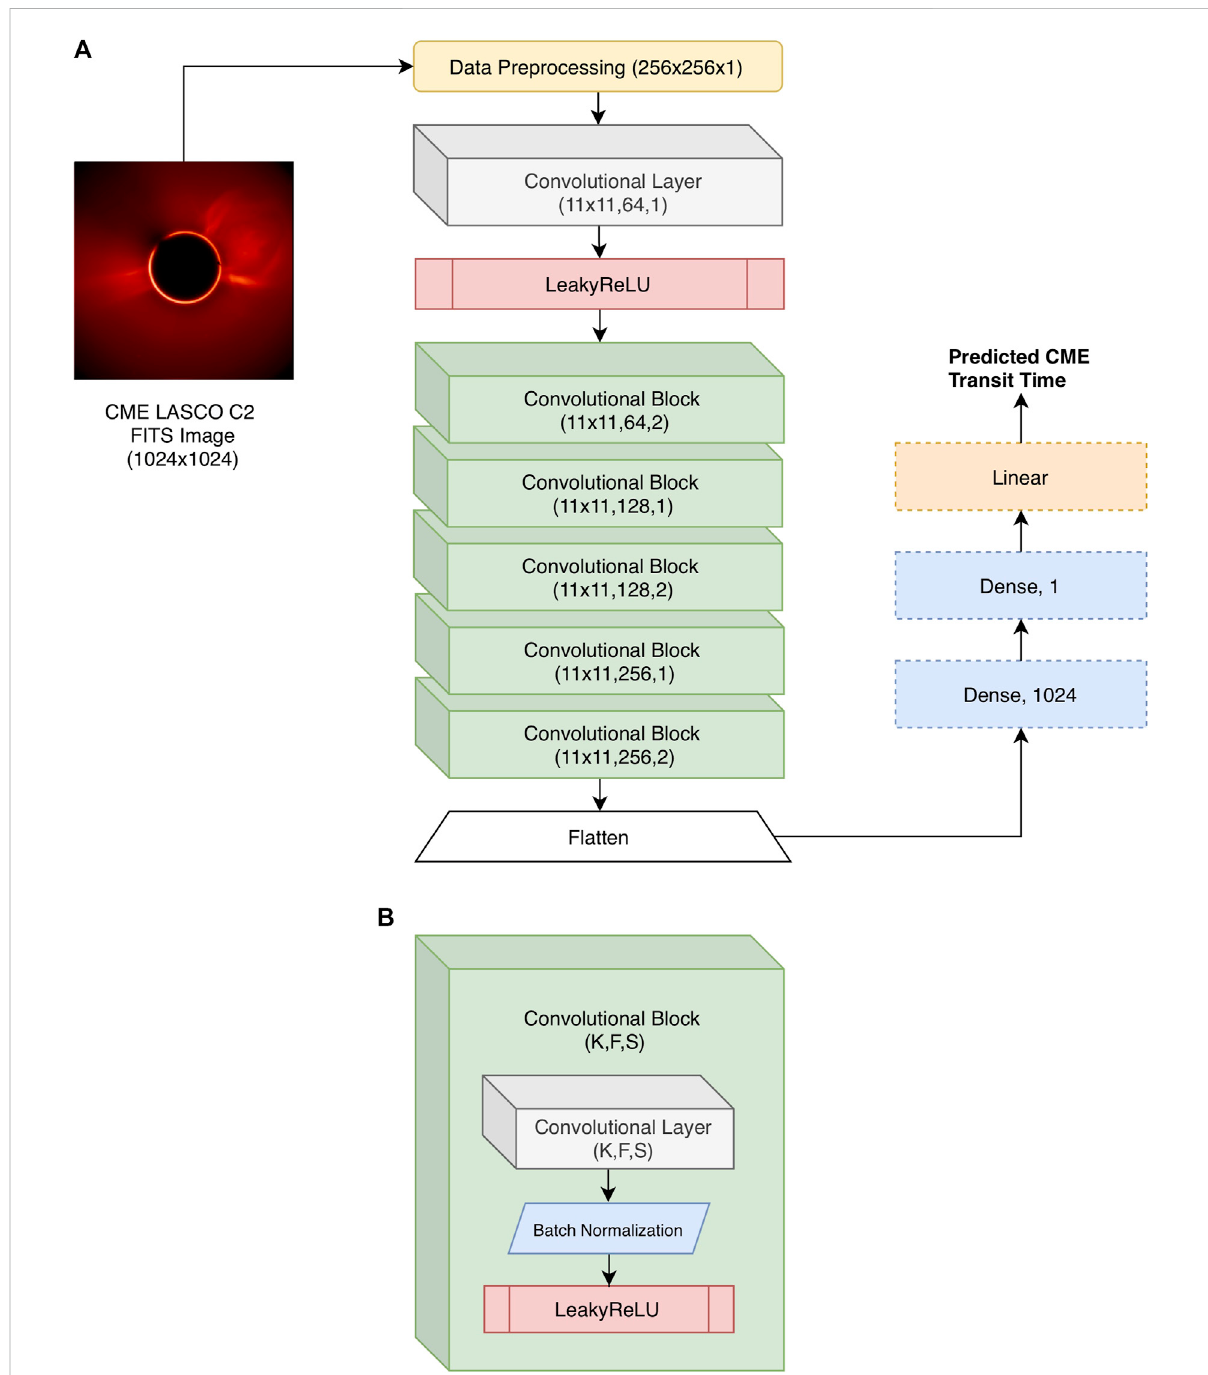
FIGURE 5 Illustrationof theCNN model in CMETNet wheretheCNN model isused to predict theCME transittime for an input CME LASCO C2 image. (A) Overall architecture of the CNN model. The model starts with a 2D convolutional layer with 64 fi lters of size 11 × 11 and 1 stride, followed by a Leaky Recti fi edLinearUnit(LeakyReLU)layer.TheoutputoftheLeakyReLUlayeristhensentto fi veconvolutionalblocks.Theoutputfeaturemapofthelast convolutional block is sent to two dense layers with 1,024 neurons and 1 neuron, respectively. Finally, the model outputs the predicted CME transit time by using a linear activation function. (B) Detailed con fi guration of a convolutional block. The convolutional block contains a 2D convolutionallayerwithF fi lterswhereF=64,128,128,256,256respectivelyandSstrideswhereS=2,1,2,1,2respectivelyandthe fi ltersizeK=11× 11. The 2D convolutional layer is followed by a batch normalization layer, which is followed by a LeakyReLU